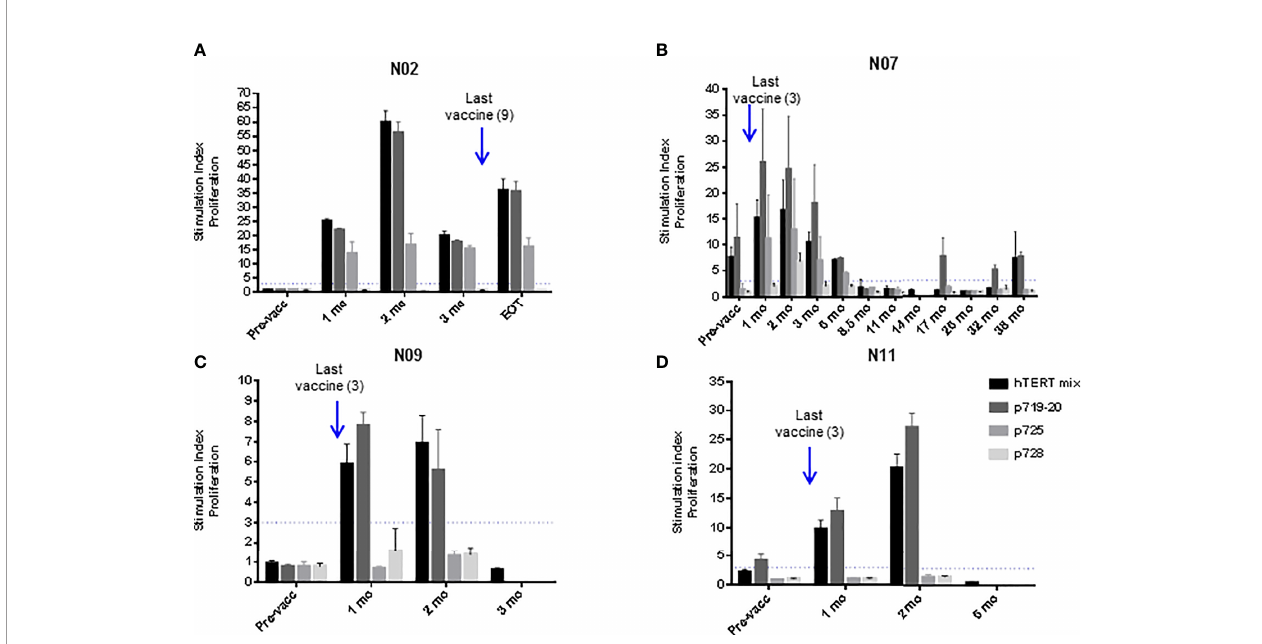
FIGURE 4 | UV1-speci fi c proliferation by T cells at different time points post-vaccination. UV1 peptide-speci fi c proliferation was measured (counts per minute, cpm) at several sampling time points and representative examples are shown for patient N02 (A) , patient N07 (B) , patient N09 (C) and patient N11 (D) . Proliferation was measured in response to peptide-loaded PBMC by 3 H-thymidine incorporation. A 3-fold increase in proliferation compared to non-peptide control (T+ APC) was considered as an immune response. Superantigen SEC-3 stimulation was included as a positive control. Dotted line indicates cut-off for positive response, measurements until last positive time point is